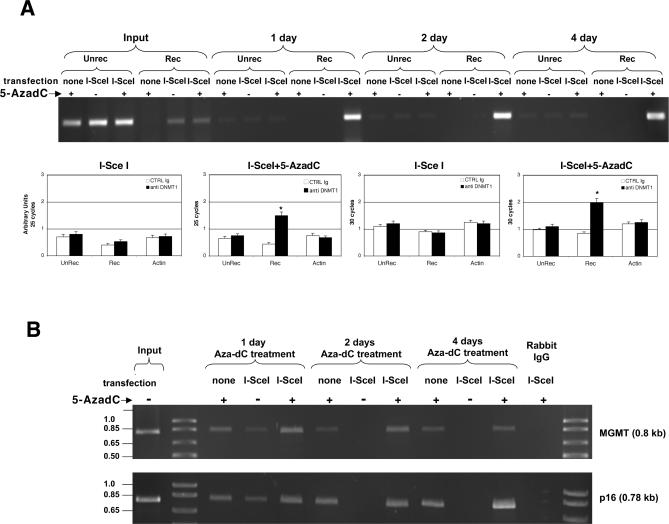
Dnmt1 Selectively Binds Recombinant GFP ChromatinHela cells carrying DR-GFP were transfected with I-SceI and treated 24 h later with 1 μM 5-AzadC for 1, 2, and 4 d. Chromatin immunoprecipitation (ChIp) was carried out as described in Materials and Methods.(A) PCR of immunoprecipitated DNA with antibodies to Dnmt1 is shown. None indicates chromatin derived from cells transfected with control plasmid, (−) or (+) indicates the treatment with 5-AzadC. Rec, unrec indicate the primers used for amplification. The lower panel shows the statistical analysis of PCR reactions carried out at 25 and 30 cycles when the reactions with the three sets of primers were in the linear range. Immunoprecipitations were carried out with nonspecific immunoglobulin G (Control immunoglobulin G) and anti-Dnmt1 specific antibodies. The primers used were: (1) unrec; (2) rec; and (3) actin (*, p < 0.01 versus control immunoglobulin G).(B) The conditions are the same as (A). MGMT and p16 indicate the primers used for amplification.